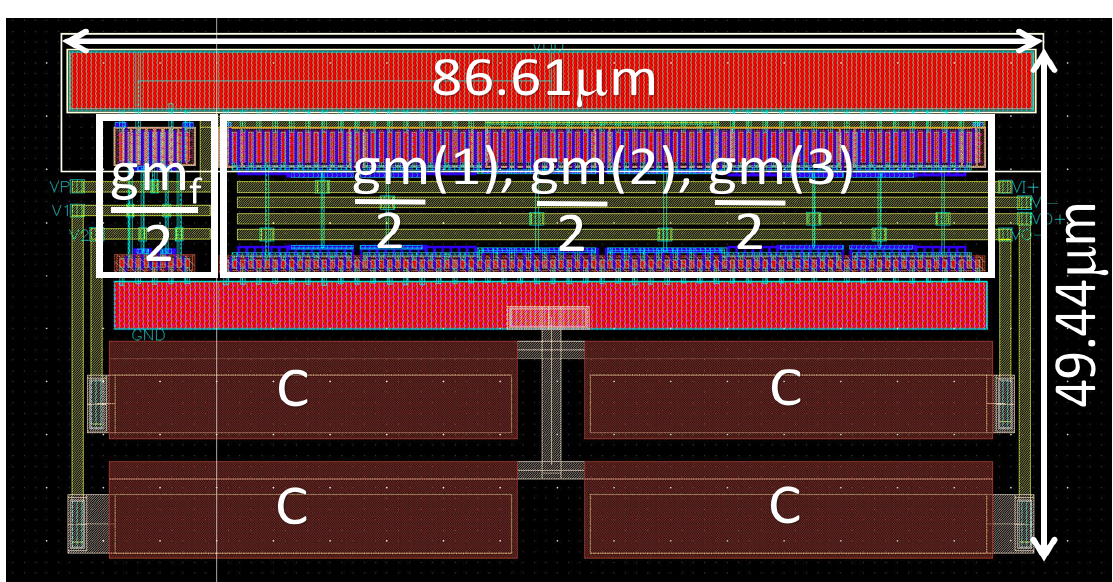
Figure 8. Layout of the proposed CMOS notch biquad in a CADENCE IC6.1.6.101 Virtuoso design